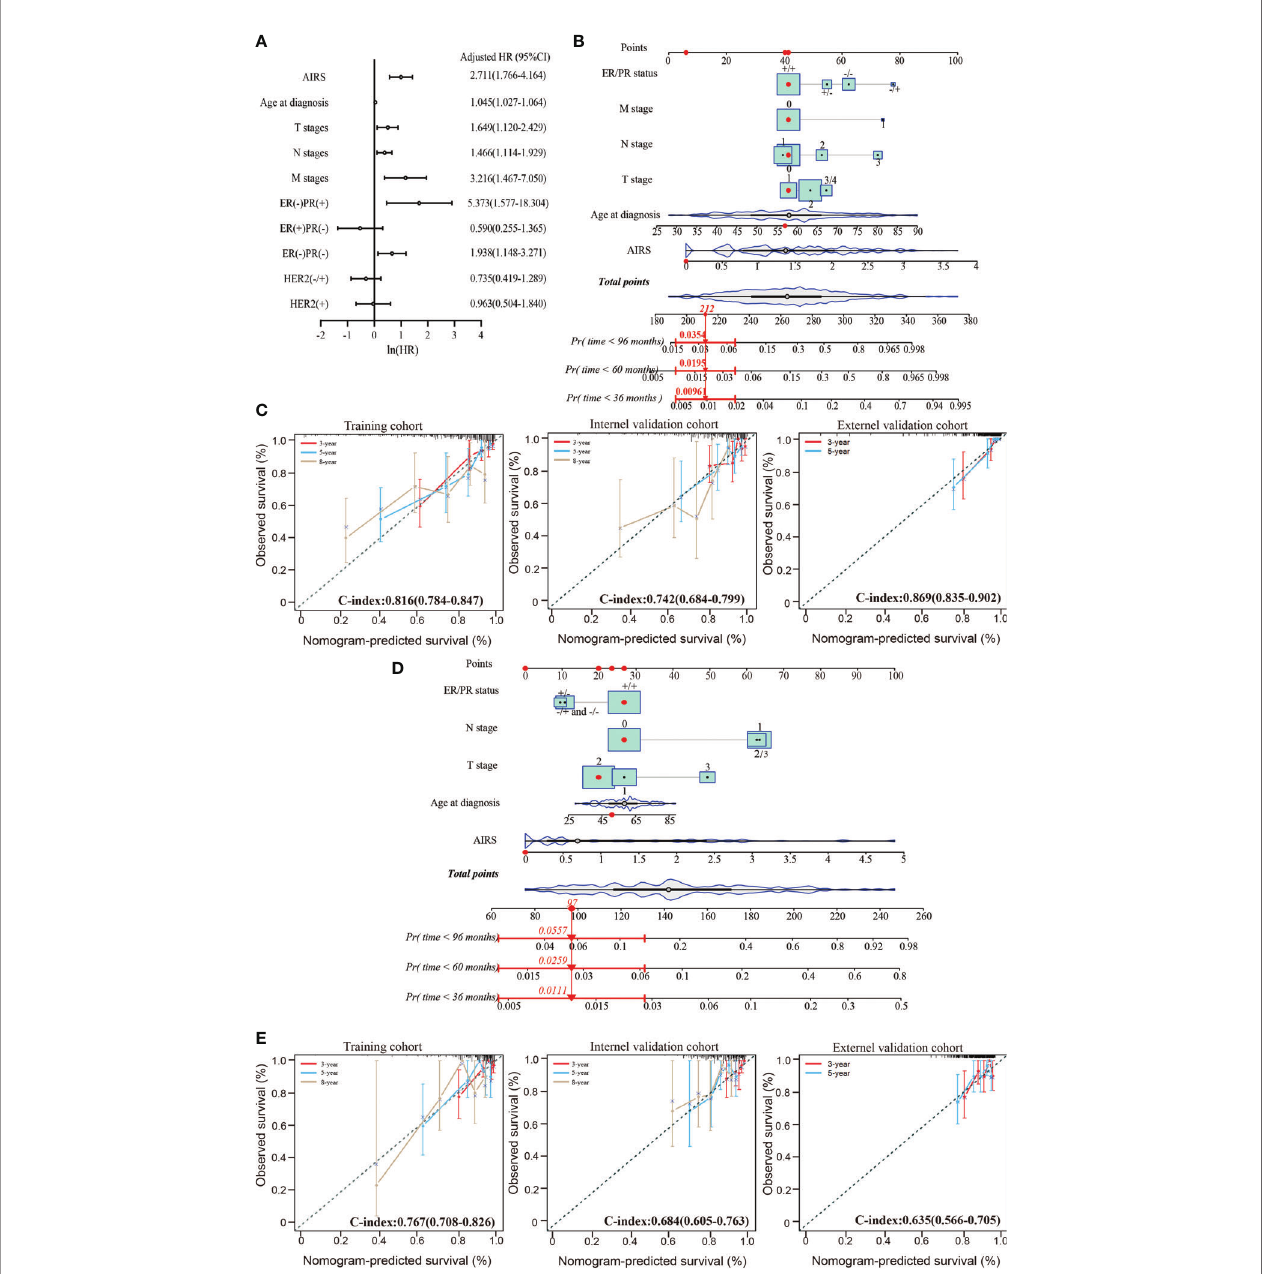
FIGURE 4 | Performance of nomogram based on the AIRS and clinicopathological features. (A) Forest plot to visualize the HRs and 95%CIs for associations between the AIRS, clinicopathological features, and OS, after the multivariate Cox-PH model. (B) AIRS nomogram predicting 36-, 60-, and 96-month OS probability of BRCA patients. Each clinicopathological variable or AIRS has a certain number of the score (top row) ranging from 0 to 100. The sum of points of each variable was related to the probability of OS at speci fi c time points (36, 60, and 96 months). The red dots and straight line with arrow show an example illustrating the use of the nomogram. This patient was one of TCGA-BRCA patients. The patient was ER + /PR + (point = 41), no lymphatic metastasis (point = 41), no distant metastasis (point = 41), T1-stage (point = 41), 57-year-old (point = 42), and 0 ATRS (point = 6); thus, the total points of this patient is 212, which corresponds to a 99.9% probability of 36-month OS, a 98.1% probability of 60-month OS, and a 96.5% probability of 96-month OS. (C) The calibration curves for predicting patients ’ OS at 3-year (red line), 5-year (violet-red line), and 8-year (tan line) in the training cohort (left), internal validation cohort (middle), and external validation cohort (right). (D) AIRS nomogram predicting 36-, 60-, and 96-month DFS probability of BRCA patient and an example illustrating the use of the nomogram. (E) The calibration curves for predicting patients ’ DFS at 3-year (red line), 5-year (violet-red line), and 8-year (tan line) in the training cohort (left), internal validation cohort (middle), and external validation cohort (right). ER, estrogen receptor; PR, progesterone receptor; AIRS, adenosine-to-inosine RNA editing-based risk score; HRs, hazard ratios; OS, overall survival; TCGA, The Cancer Genome Atlas; BRCA, breast